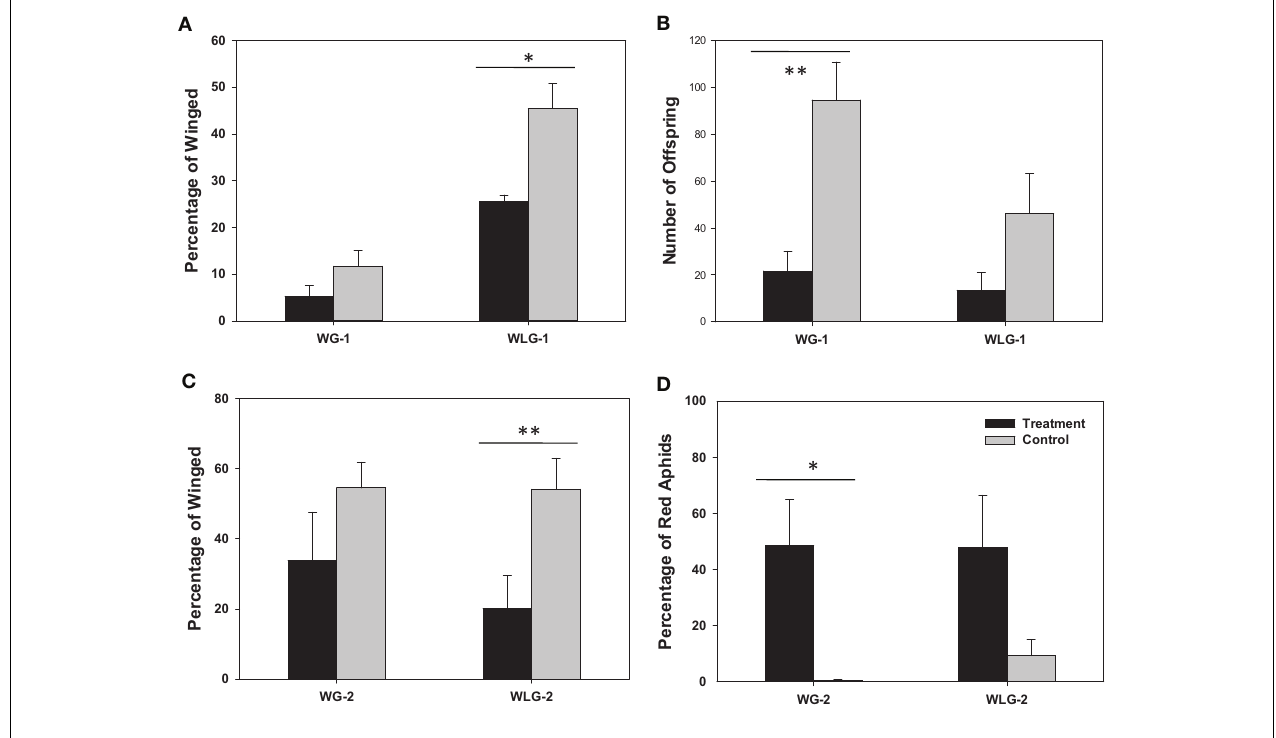
(C) and red individuals (D) among the neonatal F 2 offspring ( < 24h). * P < 0 . 05 ; ** P < 0 . 01 . WG-1/2: winged F 1 /F 2 population; WLG-1/2: wingless F 1 /F 2 population.